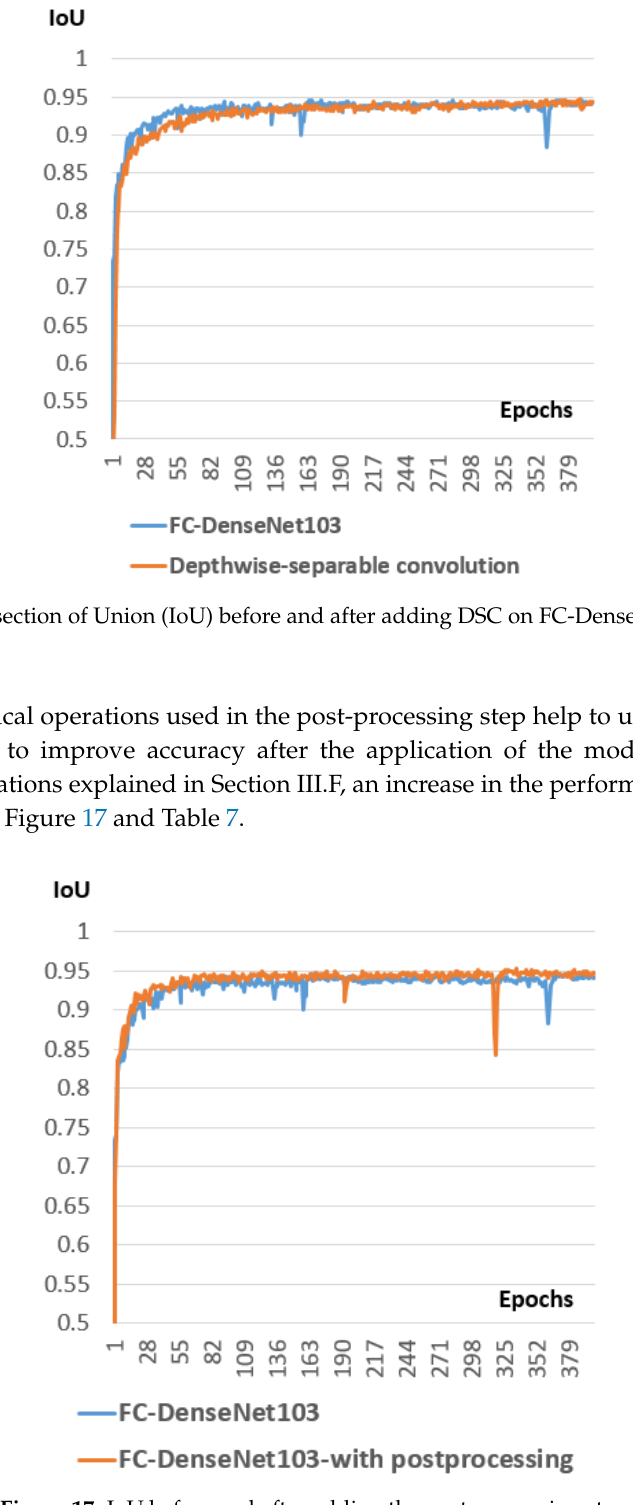
Figure 17. IoU before and after adding the post-processing